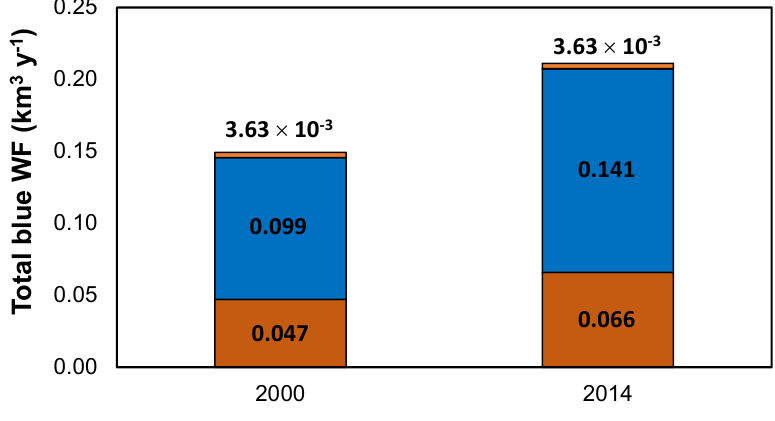
Figure 2. Total blue Water Footprint (WF) of agriculture in the Xingu Basin of Mato Grosso for the 2000 and 2014 hydrologic years.